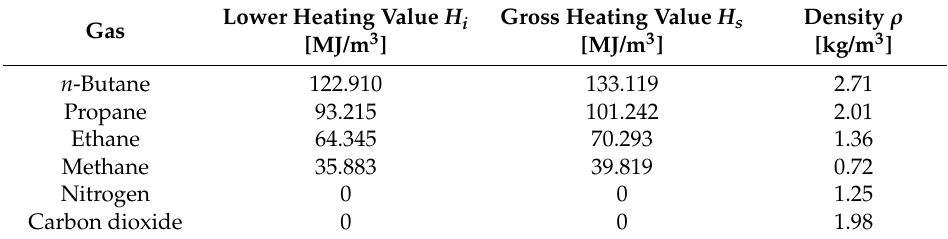
Table 2. List of lower and gross heating values as well as the gaseous density of the natural gas components